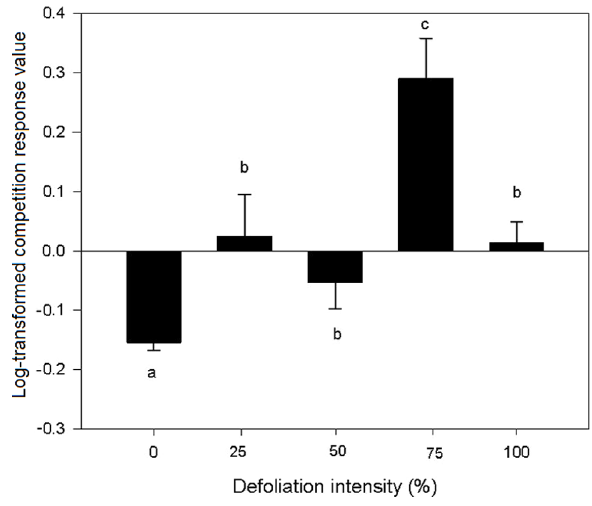
Figure 4. Log-transformed response values of Mikaniamicrantha to competition at different intensities of defoliation. Values are means ± standard deviation. Different lower case letters indicate significant differences between the defoliation intensities at p , 0.05.